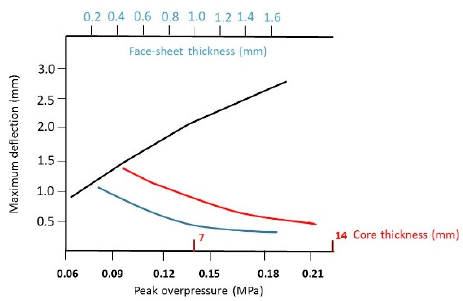
Figure 3. Deflection of panels depends on blast intensity, face thickness and core thickness. Adapted from [12].